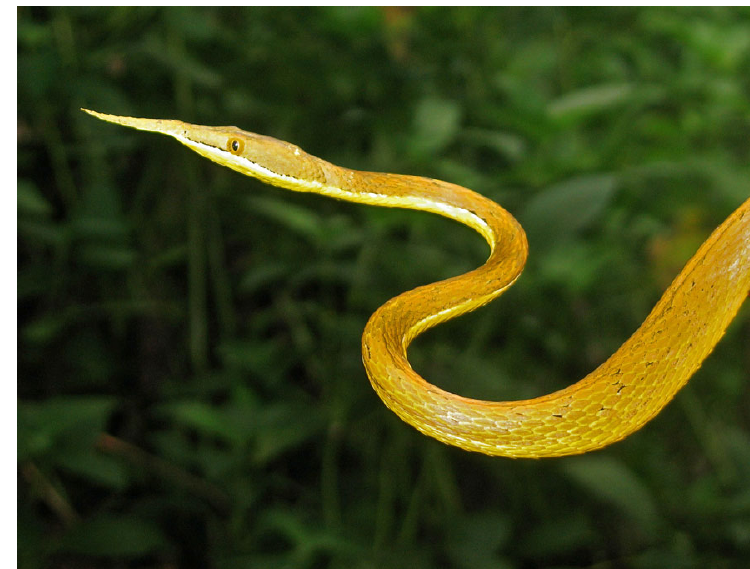
Figure 2. Langaha madagascariensis captured in the